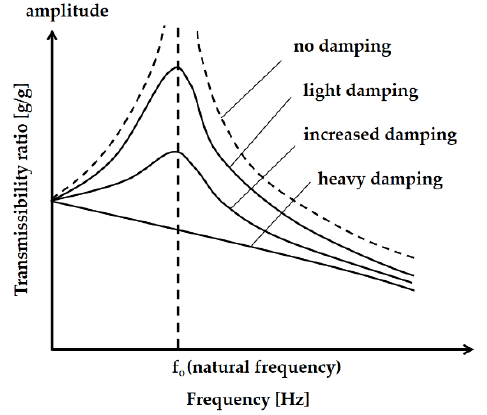
Figure 6. Transmissibility curves with varying